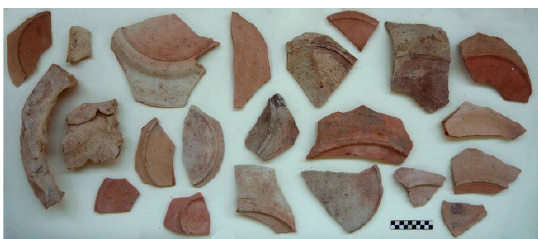
Figure 1: Sample of collected artifacts in the archaeologist site Rua das Madres,